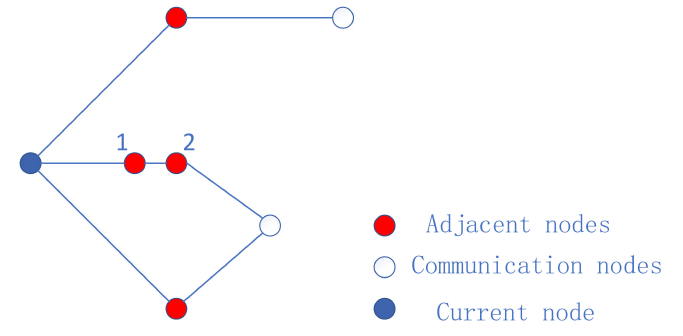
Figure 2. Schematic diagram of current node